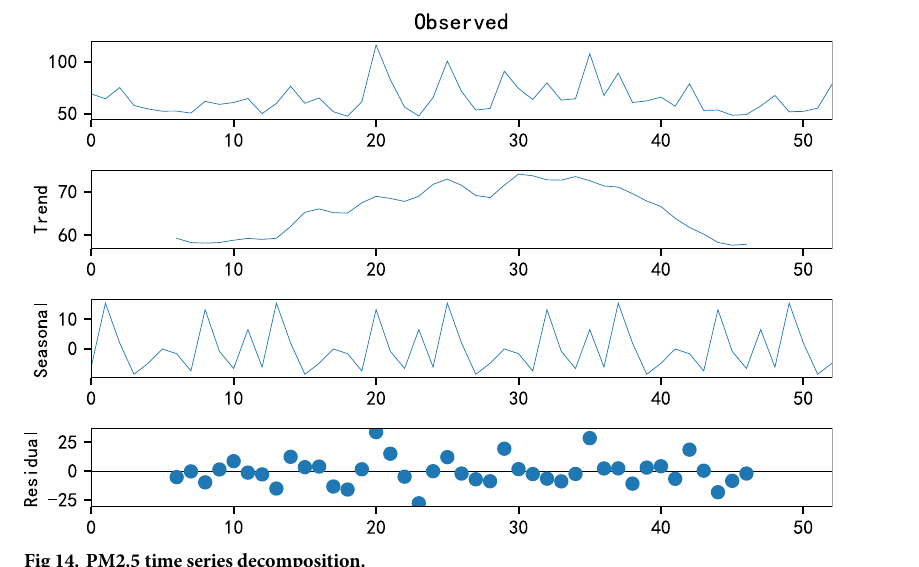
Fig 14. PM2.5 time series decomposition.